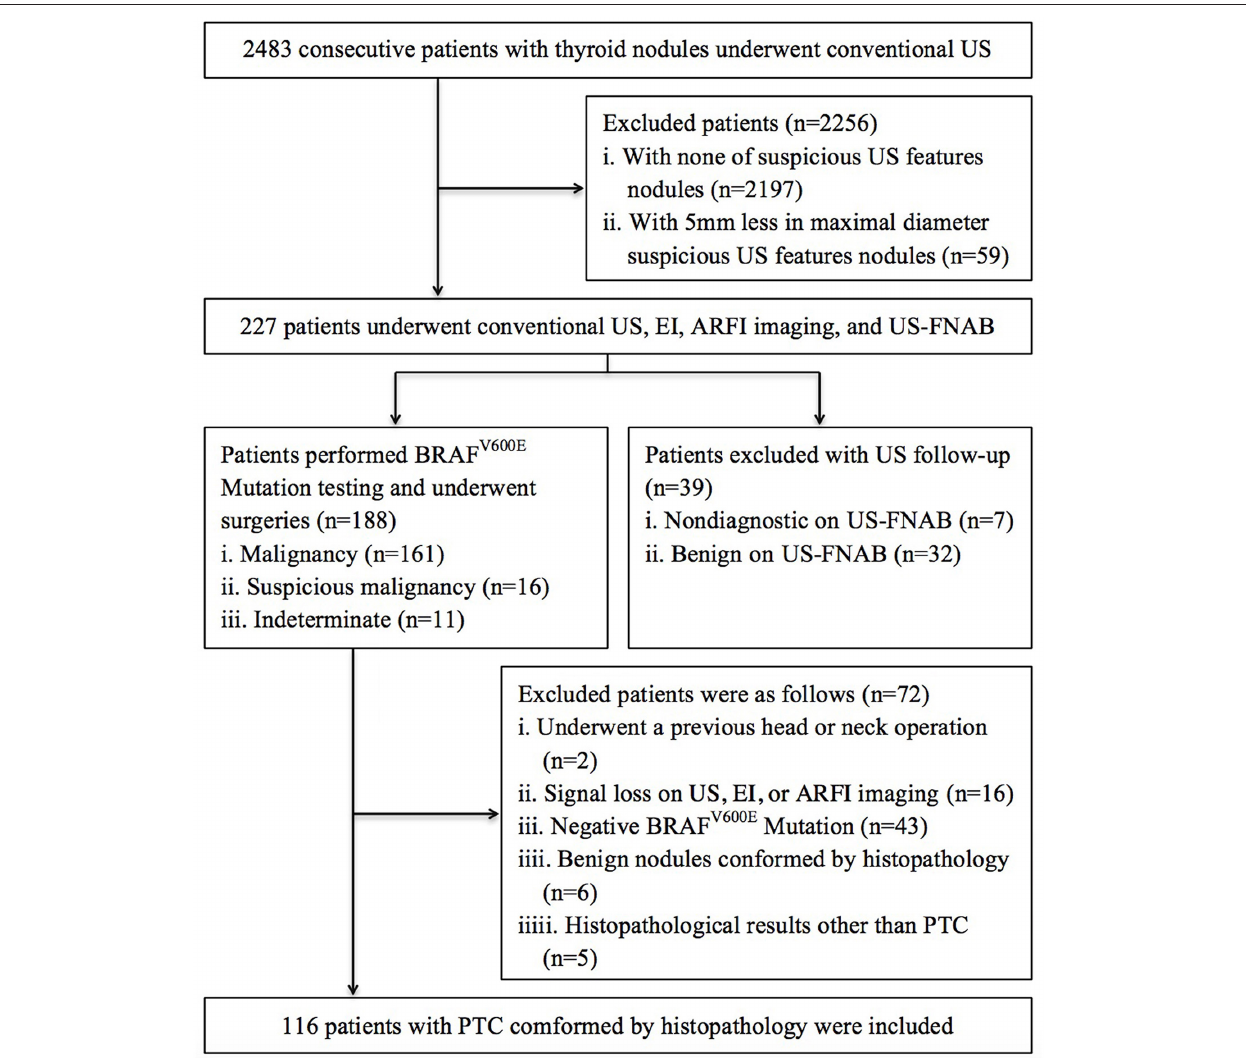
FIGURE 1 | Flowchart of the selection of the patients with